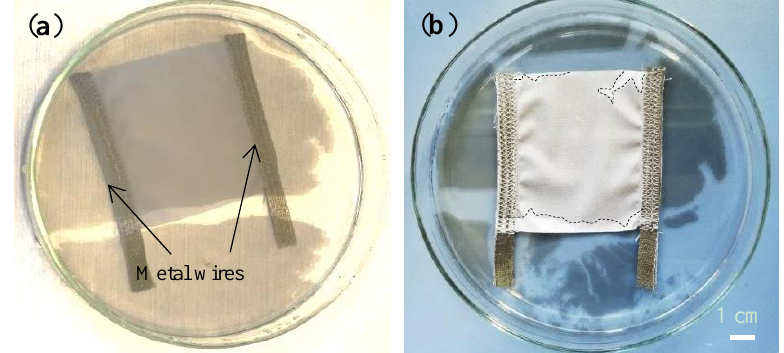
Figure 4. ( a ) DSA process for the coating of MGFs on flexible textiles interwoven with metal wires at the edges; ( b ) a uniform 30 cm 2 MGFs deposited on the textile (after drying of the textile), except for some very small blank areas at the edge of the textile (see the guiding dashed lines).